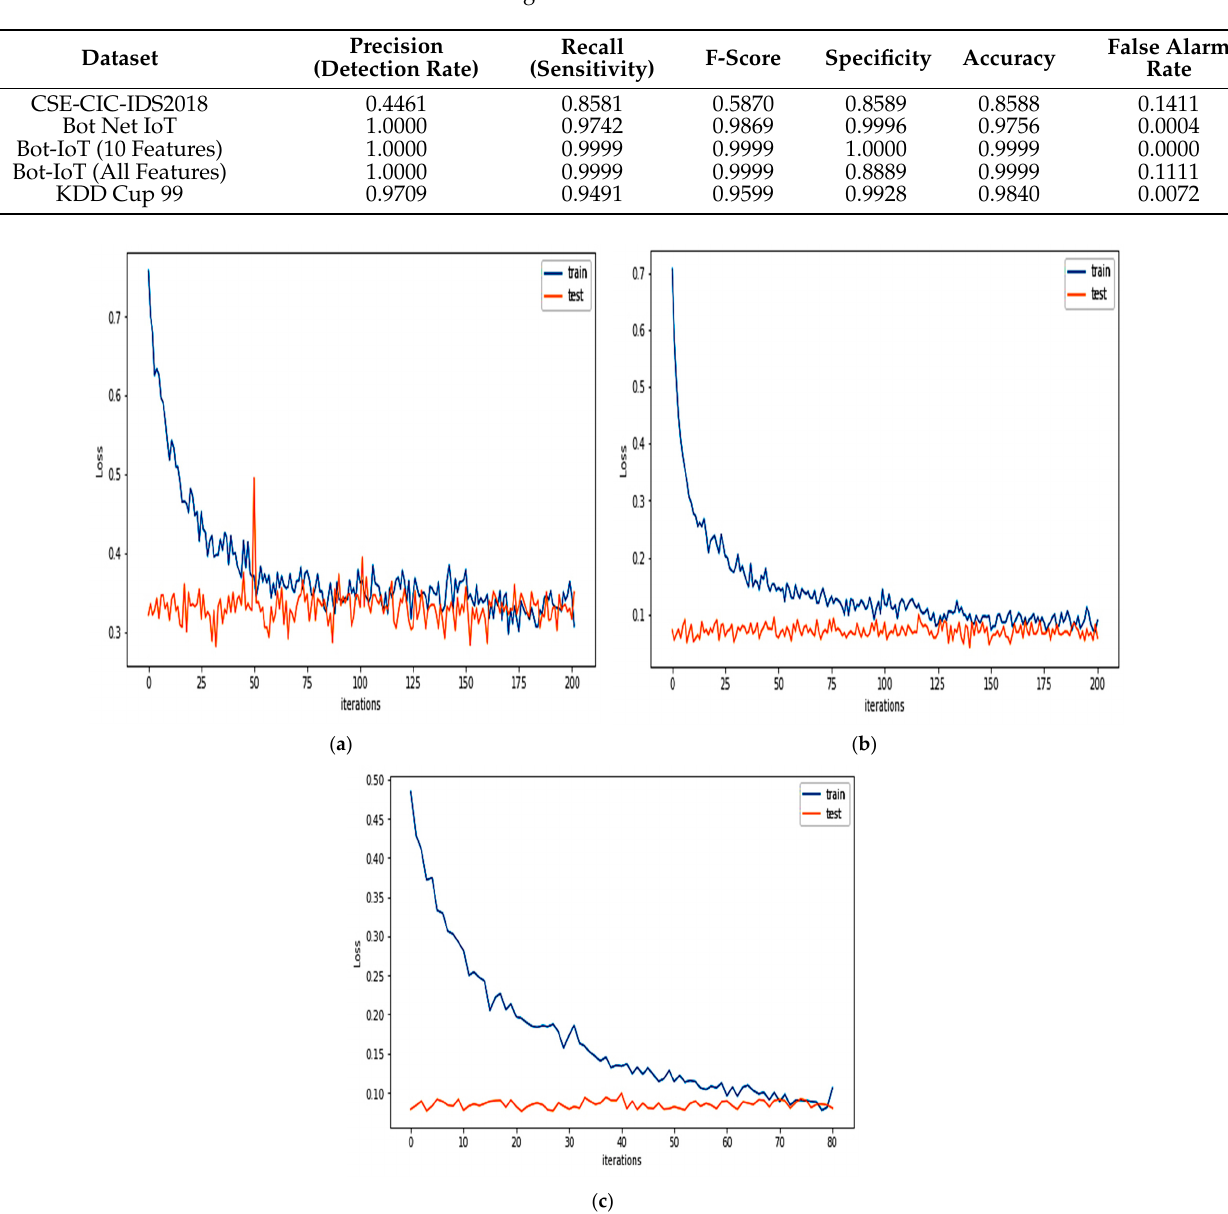
Figure 10. The average of training and testing losses of edge gateways (clients) of the proposed algorithm using: ( a ) CSE-CIC-IDS2018; ( b ) Bot Net IoT; and ( c ) KDD Cup 99.